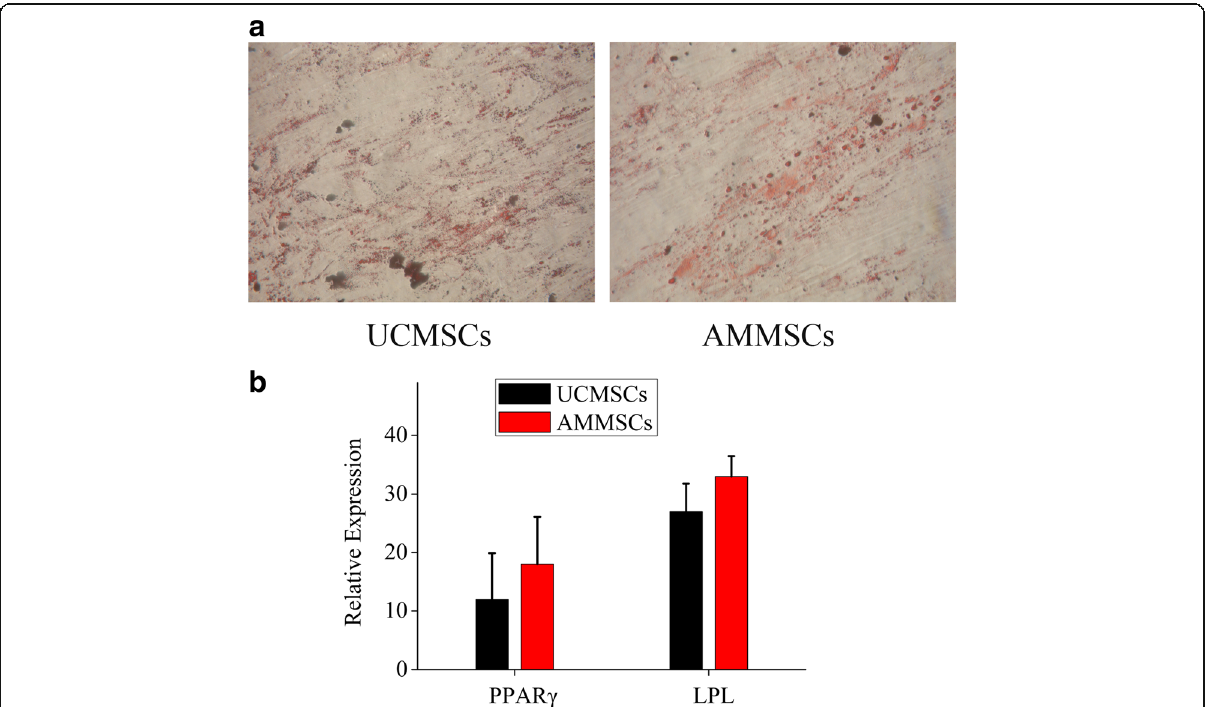
Fig. 5 AMMSCs in PL showed similar adipogenic differentiation potential with UCMSCs. a The adipogenic differentiation of AMMSCs and UCMSCs was confirmed by Oil Red O staining of lipid vacuoles. Magnification × 100. b Comparative investigation of adipogenic differentiation capability of UCMSCs and AMMSCs was assessed by quantitative analysis of PPARg and LPL mRNA expression. Bars represented means ± SD; n =